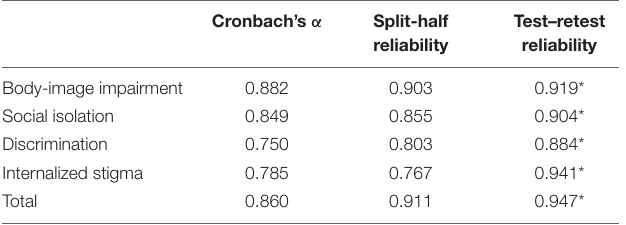
TABLE 4 | Reliability correlations for the Breast Cancer Stigma Scale ( N =